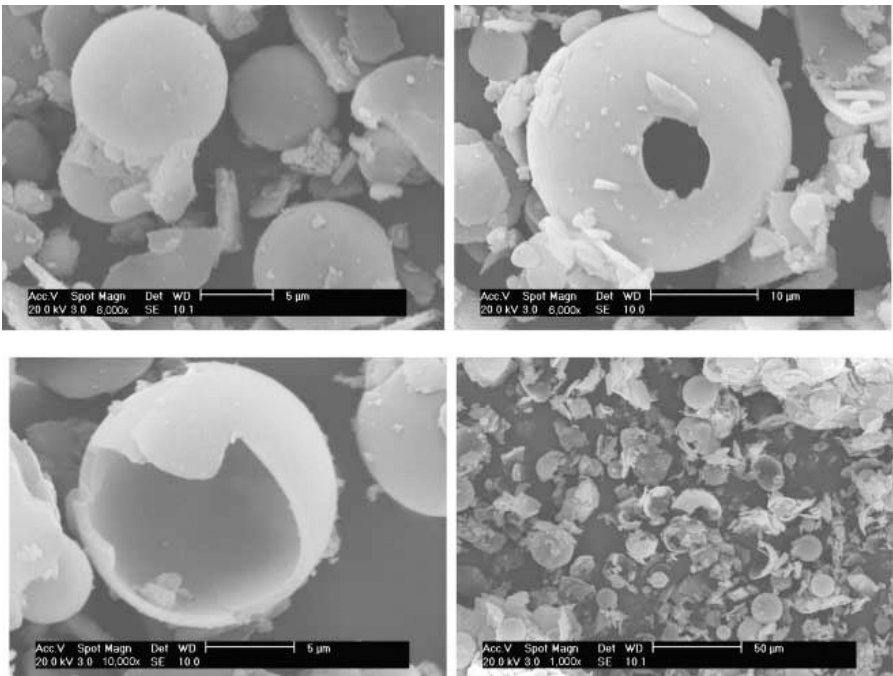
Figure 4. SEM images of hollow silicon dioxide spheres. Republished with permission of Royal Society of Chemistry, © 2005, from Ref. [26].